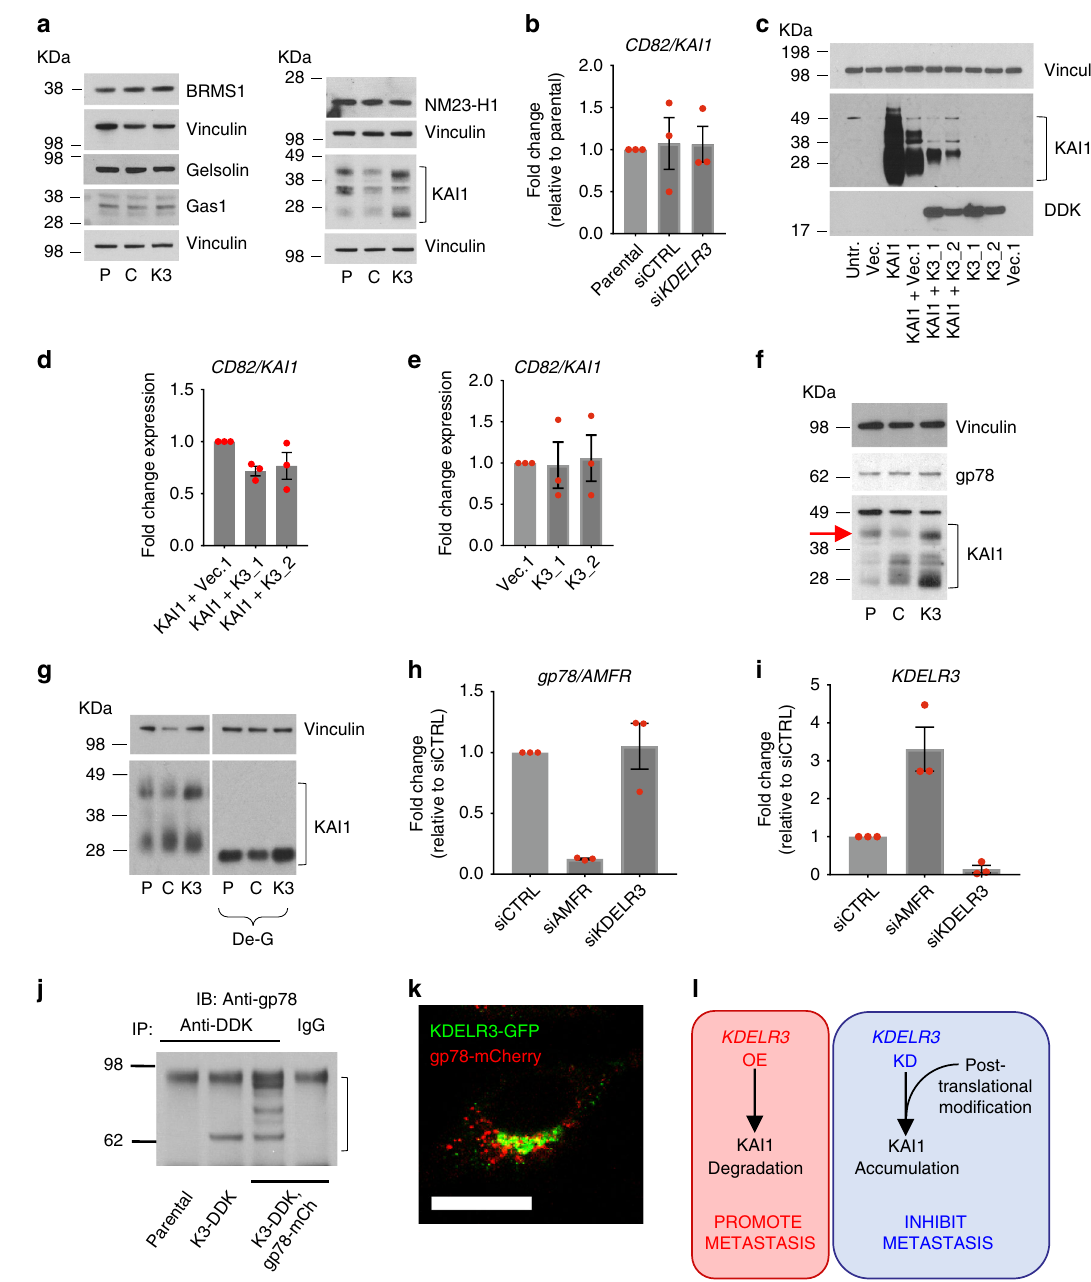
Fig. 5 KDELR3 regulates expression and processing of the metastasis suppressor KAI1. a Screen of known melanoma metastasis suppressor expression following KDELR3 knockdown (3 days post knockdown). P, parental; C, siControl; K3, si KDELR3 . b qPCR of KAI1 RNA expression ( CD82 gene) in siRNA- knockdown cells (indicated), 3 days post knockdown. c – e KAI1 protein ( c ) and RNA ( d , e ) expression in 1205Lu cells transfected with CD82/KAI1 overexpression (KAI1) or PCMV6-AC control vector (Vec.), KDELR3 transcript 1 with DDK tag (K3_1), KDELR3 transcript 2 with DDK tag (K3_2), or PCMV6 control vector (Vec.1). They were harvested 3 days post transfection. Equal protein amounts subjected to immunoblot analysis with an anti-KAI1 and anti- DDK antibody and anti-vinculin loading control ( c ). f 1205Lu cells parental (P), and 1205Lu cells transiently transfected with control siRNA (C), and KDELR3 siRNA (K3), harvested 3 days post transfection and equal protein amounts subjected to immunoblot analysis with an anti-KAI1 and anti-gp78 antibody. Red arrow indicates high-molecular-weight KAI1. g KAI1 protein expression in siRNA-knockdown (indicated) 1205Lu cells harvested 3 days post transfection and treated with deglycosylation enzymes (De-G). h qPCR of gp78 RNA expression ( AMFR gene) in siRNA-knockdown cells (indicated), 4 days post knockdown. f , g Anti-vinculin antibody used to control for protein loading. i qPCR of KDELR3 RNA expression in siRNA-knockdown cells (indicated), 4 days post knockdown. j Co-immunoprecipitation of endogenous gp78 and mCherry-tagged gp78 (gp78-mCh) with FLAG-tagged KDELR3 (K3-DDK) in stably transduced 1205Lu cells. k pol2 > KDELR3 -GFP (green) co-localizes with pol2 > gp78 -mCherry (red) in 1205Lu metastatic melanoma cells. Scale bars, 50 µ m. l Schematic of the KDELR3 – KAI1 axis in melanoma metastasis. a Representative of four independent experiments. b – f , h , j – k Representative of three independent experiments. g , i Representative of two independent experiments. b , d , e , h , i Bars and error bars represent mean ± s.e.m. N = 3 (representative of three independent experiments). a , c , f , g Square brackets depict KAI1 molecular weights. j Square bracket depicts all forms of gp78, including endogenous and mCherry-tagged